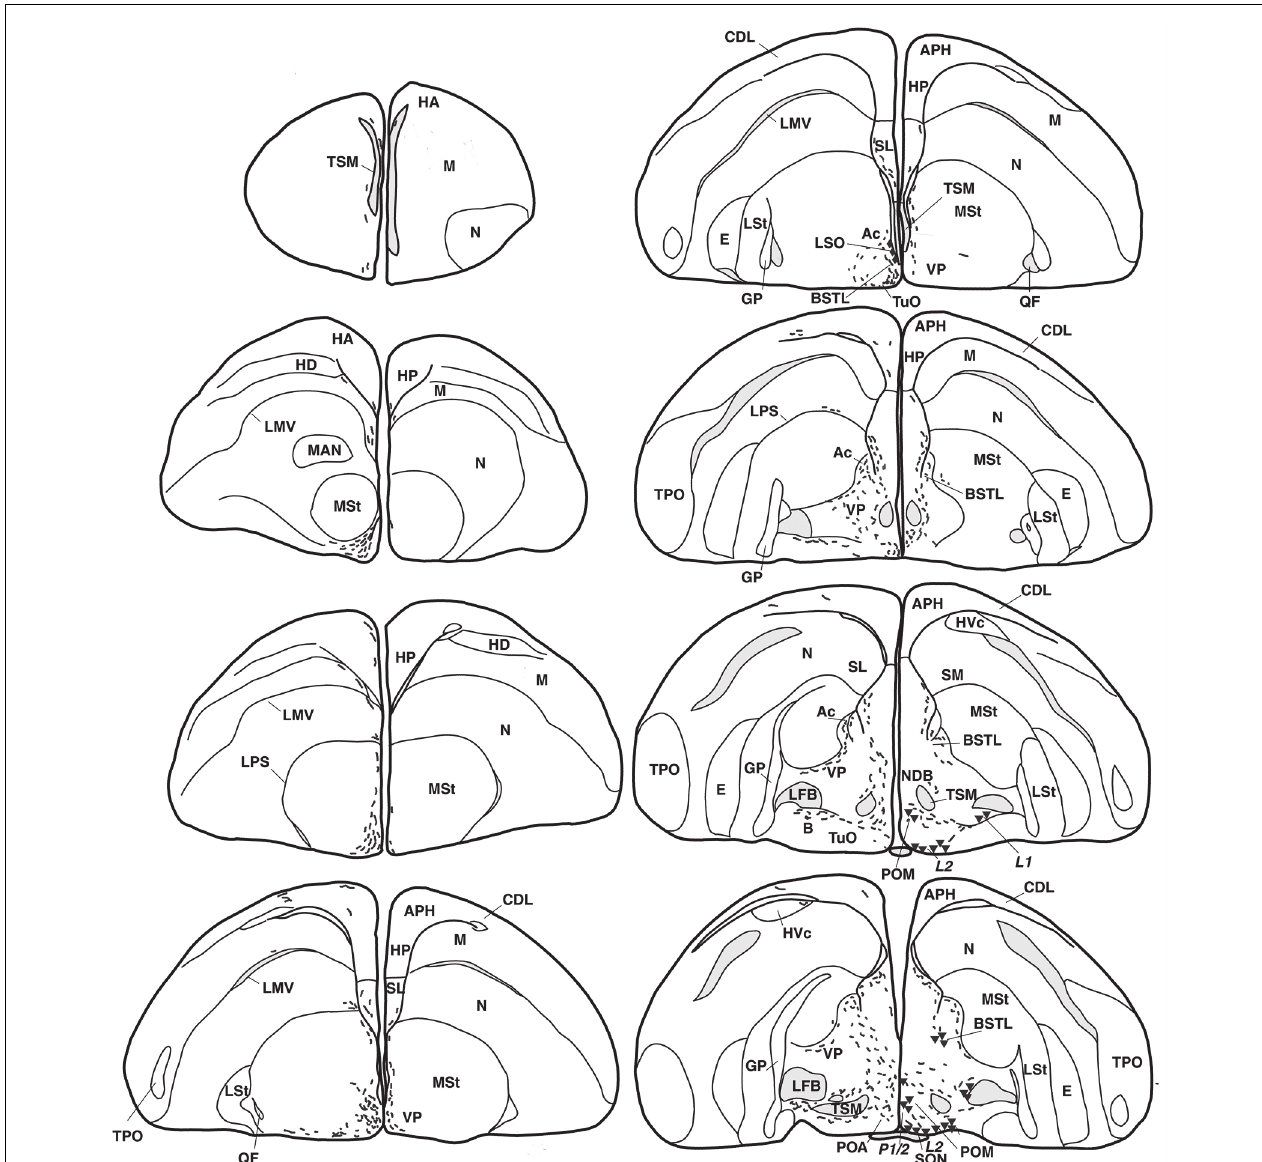
DMN, medial dorsal hypothalamic nucleus; DMP, posterior dorsomedial thalamic nucleus; DSV, ventral supraoptic decussation; E, entopallium; EW, nucleus of Edinger–Westphal; FLM, medial longitudinal fascicle; FRL, lateral mesencephalic reticular formation; FRM, medial mesencephalic reticular formation; GCt, central gray; GLv, ventral part of the lateral geniculate nucleus; GP, globus pallidus; HA,apical part of the hyperpallium; HD,densocellular part of the hyperpallium; HL, lateral habenular nucleus; HM, medial habenular nucleus; HP, hippocampal formation; HVC, higher vocal center; ICo, intercollicular nucleus; IMc, magnocellular part of the isthmic nucleus; IP, interpeduncular nucleus; IPc, parvocellular part of the isthmic nucleus; L1-L4 , hypothalamicvasotocinergiccellsgroups(Berketal.,1982);LA,lateralanterior thalamic nucleus; LMV, lamina mesopallialis ventralis/lamina mesopallialis; LC, nucleus linearis caudalis; LFB, lateral forebrain bundle; LM, mesencephalic nucleus lentiformis; LoC, locus coeruleus; LPS, lamina pallio-subpallialis;